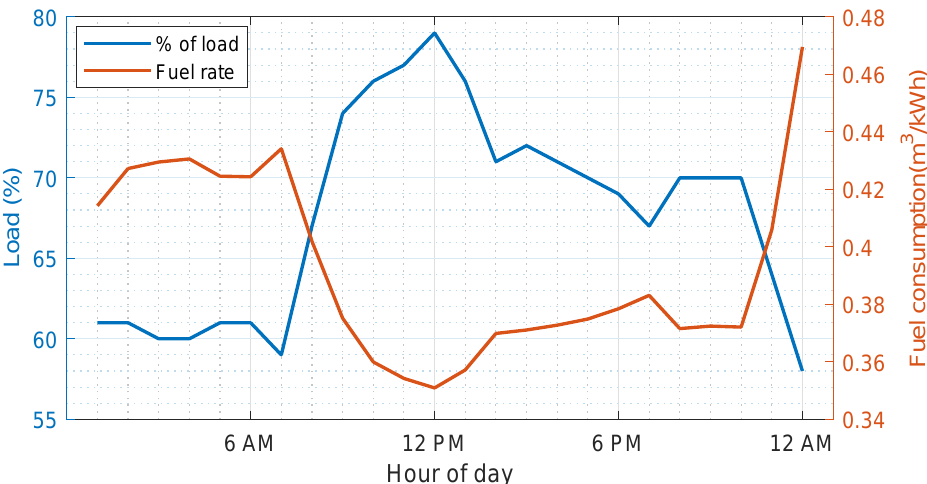
Figure 11. Hourly variation of load and fuel consumption rate (m 3 /kWh) for the month of January